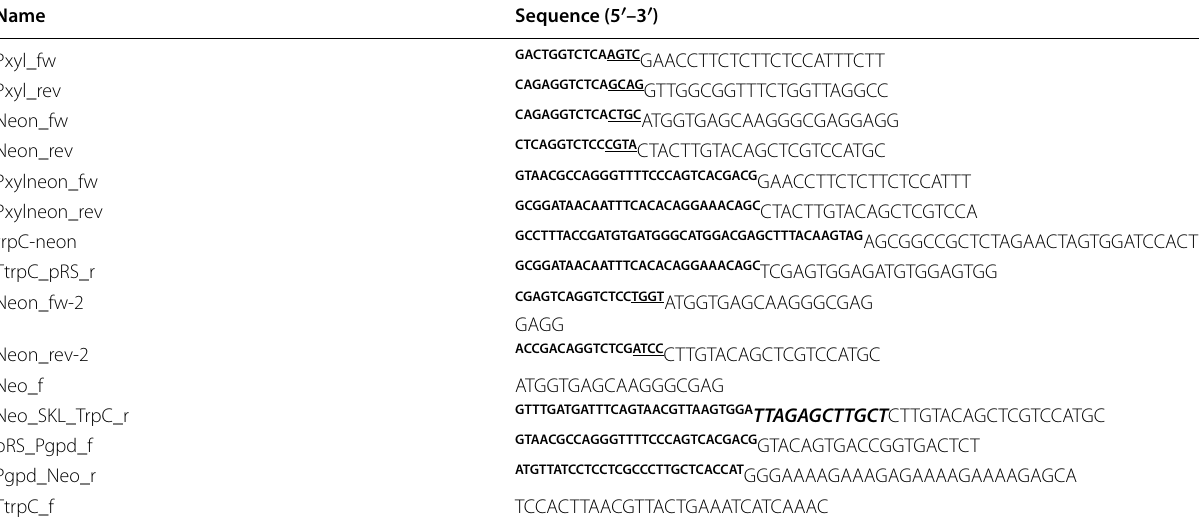
bold superscript overhang; superscript underlined = T terminator, P